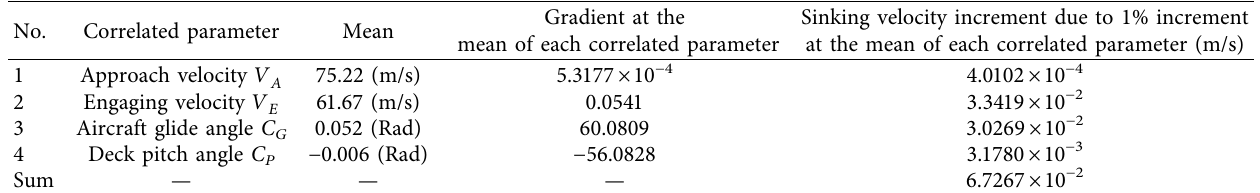
Table 6: The influence degree of the correlated parameters on the sinking velocity.